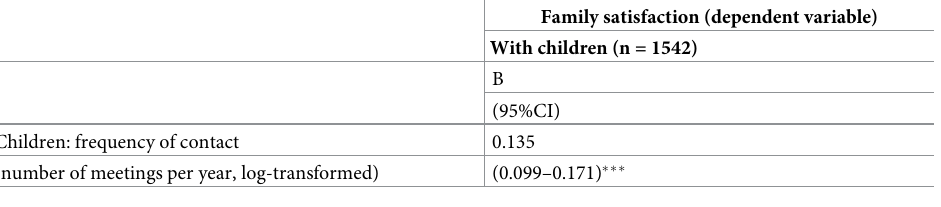
Table 4. Association of satisfaction with family and frequency of contact in participants with children. Linear regression adjusted for sex and